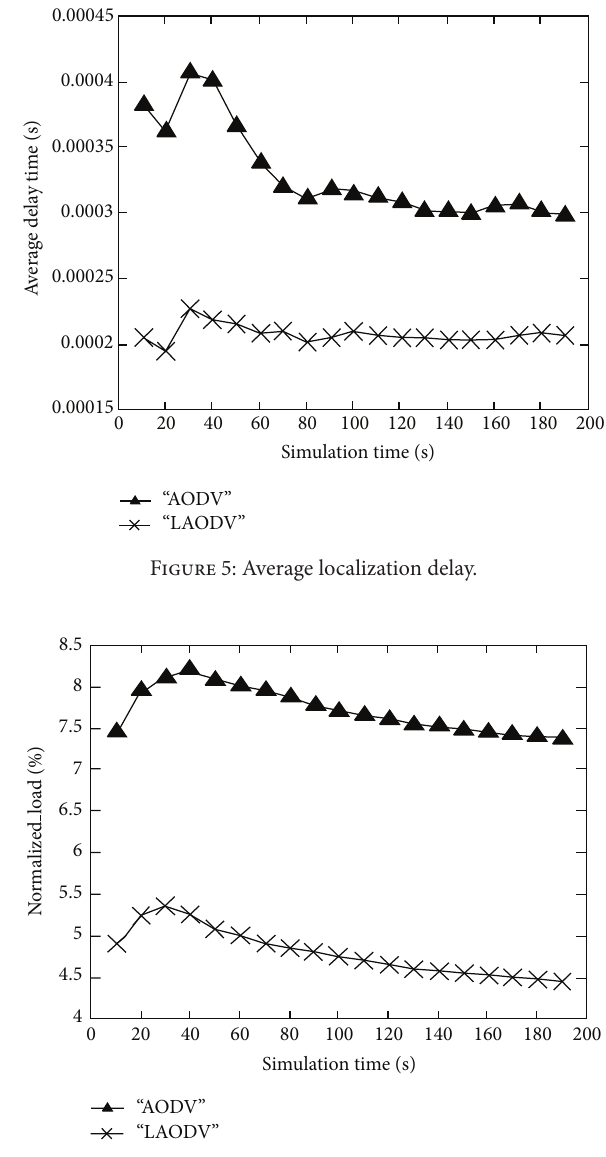
Figure 6: System overhead during location